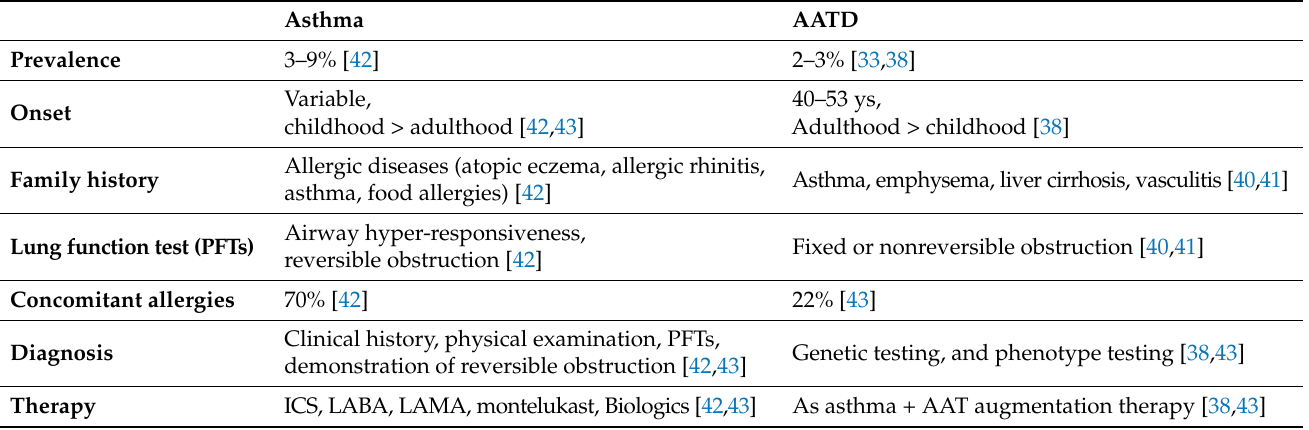
Table 1. Main distinguishing features of asthma and α 1-Antitrypsin deficiency